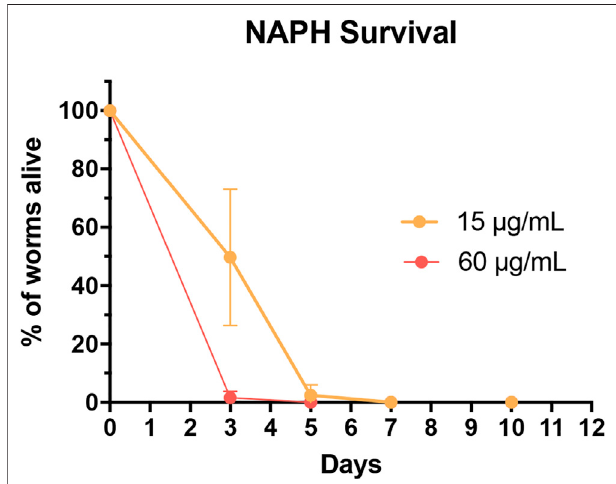
FIGURE 9 | Survival curves of worms treated with 60 μ g/ml (red; corresponds to 315.54 µM) and 15 μ g/ml (orange; corresponds to78.89 µM) NAPH. Dots represent counting events as mean of three parallel experiments ±SD. The survival curve for DMSO-treated worms (throughout the experiment at 100%) is not